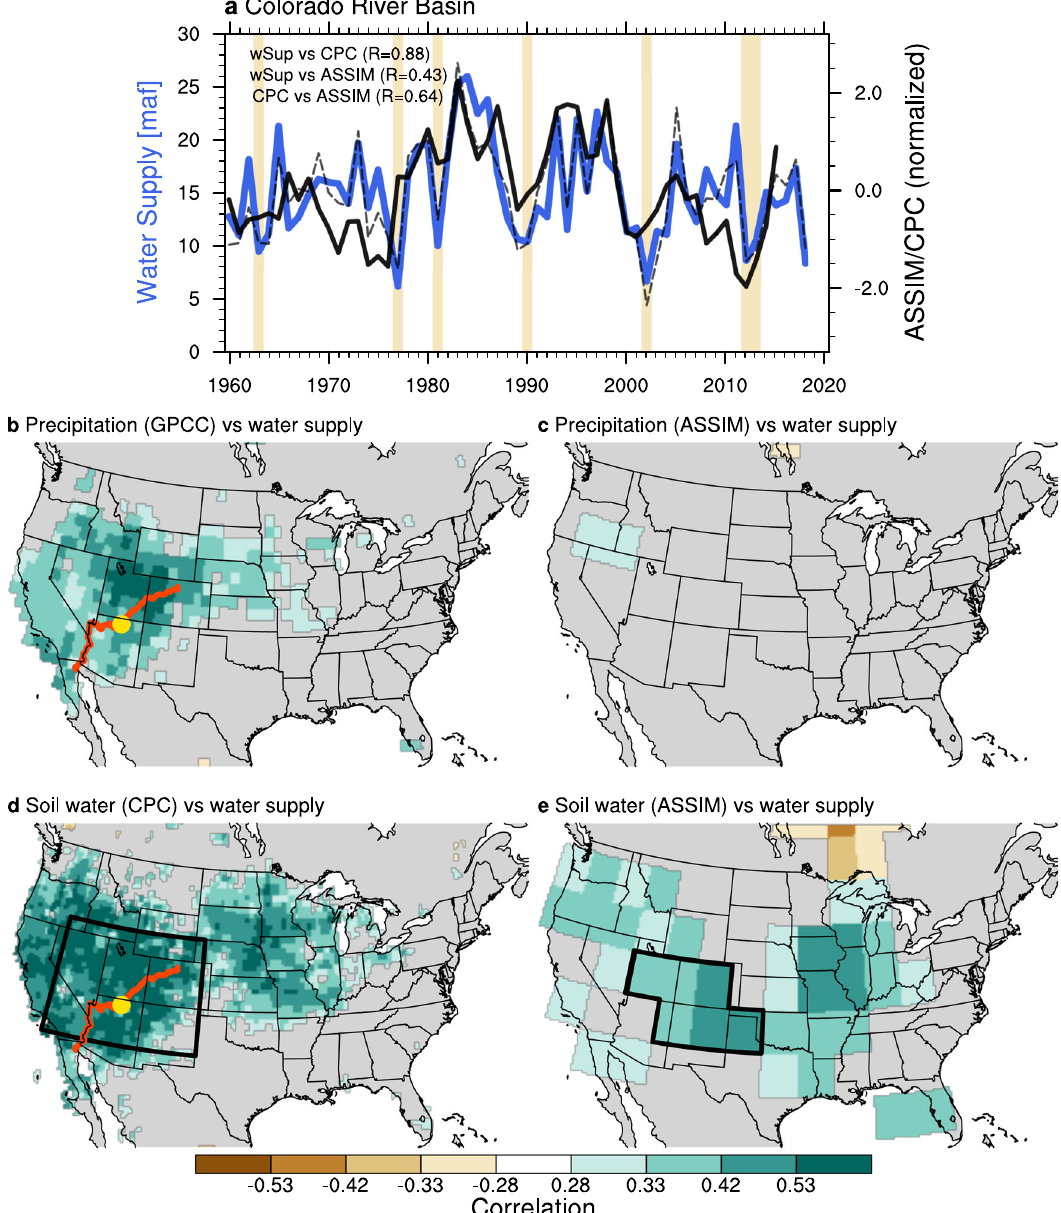
Fig. 1 Observed and reconstructed Colorado River water supply. a Annual mean time series of Colorado River water supply (blue) and its reconstructions by CPC soil moisture reanalysis (black broken) and the ensemble mean of 10-member ASSIM runs (black solid). The reconstructions of the Colorado